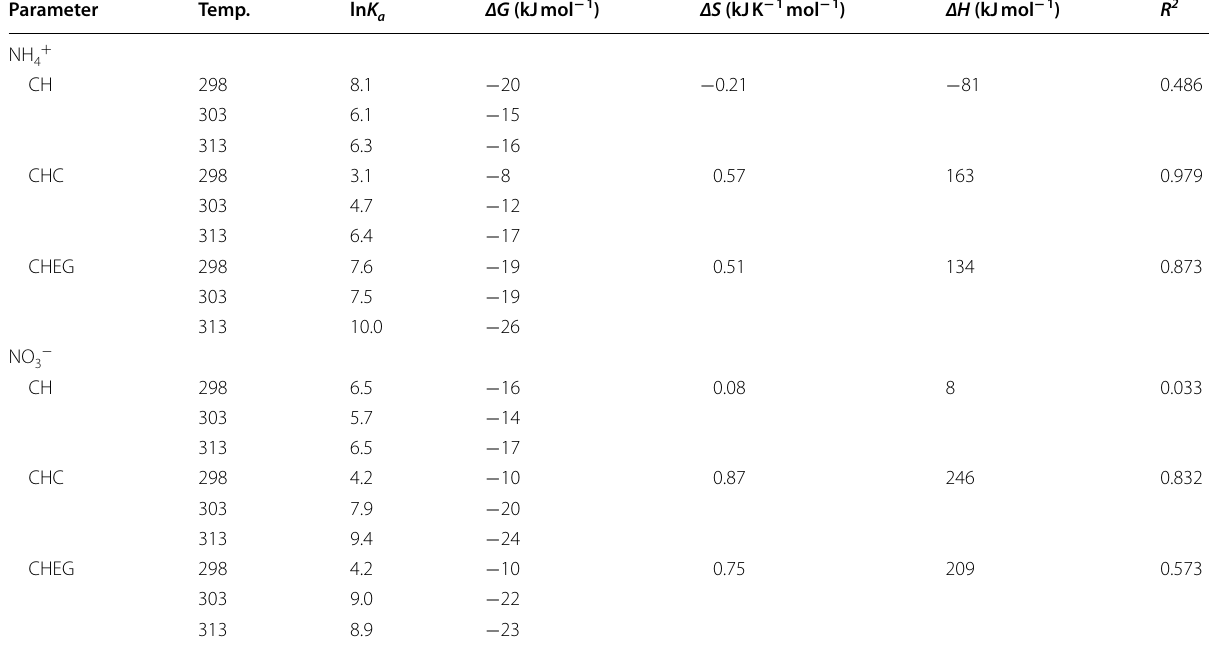
and NO adsorption in single solute solution 4 + 3 −